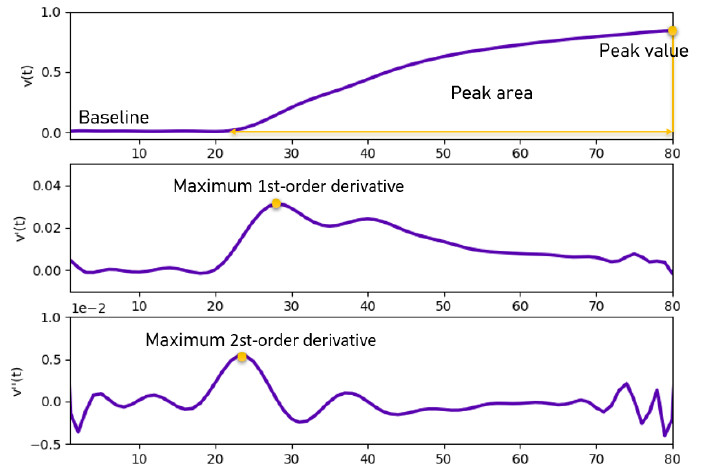
phases of data acquisition. Thus, the first 17 s of data acquired by the electronic nose were